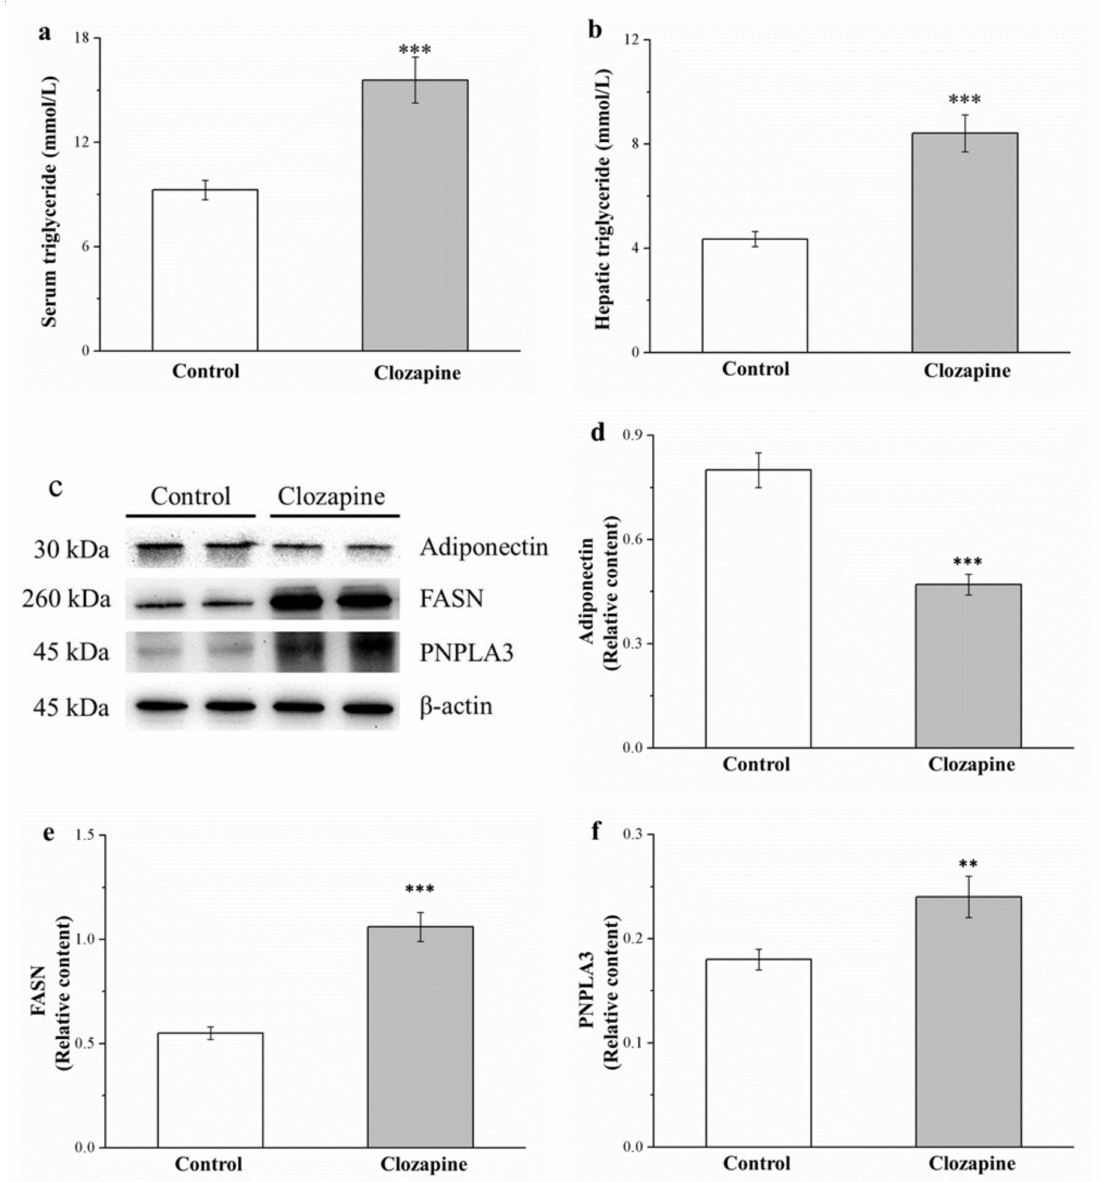
Figure 5. ( a ) Serum and ( b ) hepatic triglyceride levels. ( c ) Representative Western blot of liver extracts. ( d ) Adiponectin, ( e ) FASN, and ( f ) PNPLA3 expression. Data are mean ± standard deviation ( n = 10). ** p < 0.01, *** p <